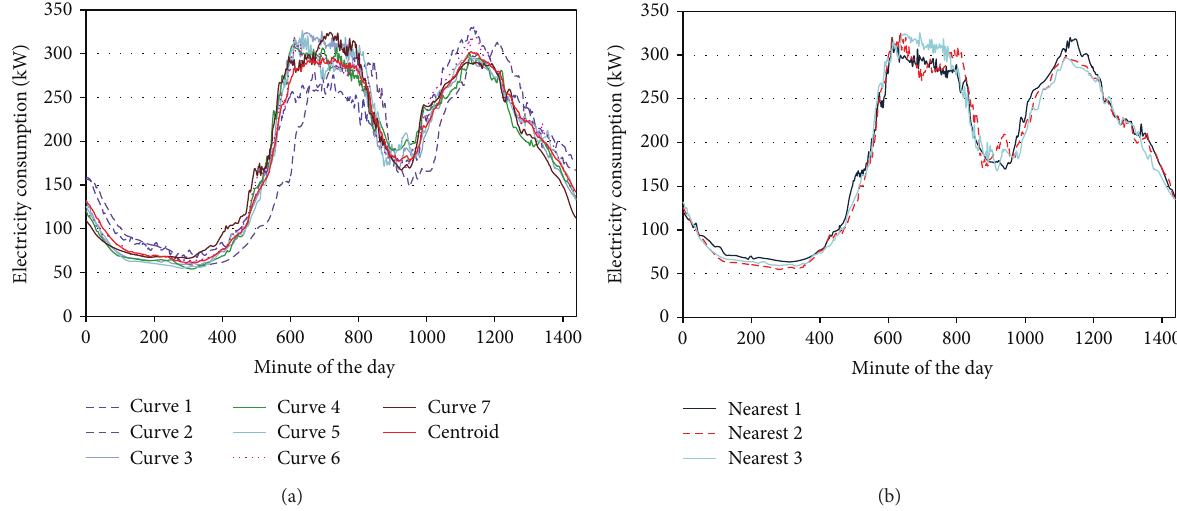
Figure 11: (a) The load curves in the crisis period cluster and centroid of the base date. (b) The three nearest curves during the crisis period.